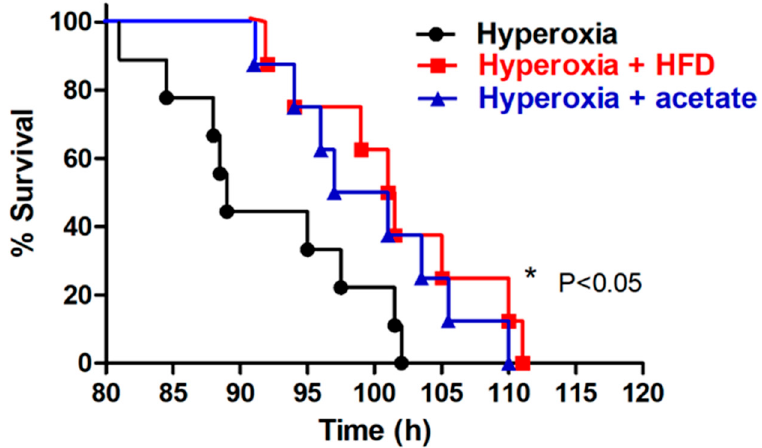
Figure 1. A high-fiber diet (HFD) and acetate supplementation prolong the survival of mice. under hyperoxia conditions. Representative Kaplan-Meier survival curves of mice exposed to 100% oxygen. * p < 0.05, log-rank test.